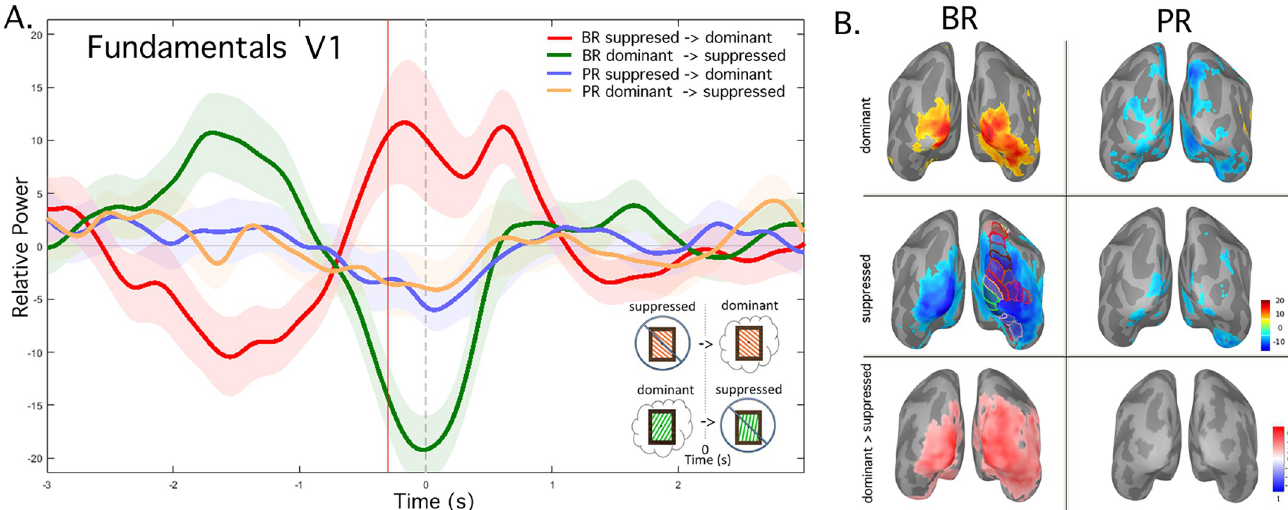
Fig 2. Dominant vs. suppressed fundamental frequency power difference. BR vs. the PR control, group-average (n = 10) A. Power fluctuations over time extracted from right V1. The gray vertical dashed line indicates the time of button press (0 sec) while the red vertical line marks 300 ms prior to the press. For BR, red or green lines show power at the frequency that was perceptually dominant or suppressed after button press, respectively. Pale color fill indicates the standard error of the mean (SEM). For PR control, the same analysis is indicated with blue or yellow lines. B. Dominant (top row) and suppressed (middle row) power was extracted at -300 ms for each condition, for BR (left column) and PR control (right column), and plotted on the inflated cortical surface. Shown also (left column, 2 nd row), a probabilistic atlas (Wang, et.al 2015) co-registered to Freesurfer’s fsaverage brain was overlaid on the right hemisphere to provide a reference for visual regions of interest, shown here in multiple colors depicting individual regions. The upper and lower bank of V1 is indicated in bright green in this and subsequent figures. Bottom row shows the regions with a significant difference between the dominant and suppressed power at -300 ms.